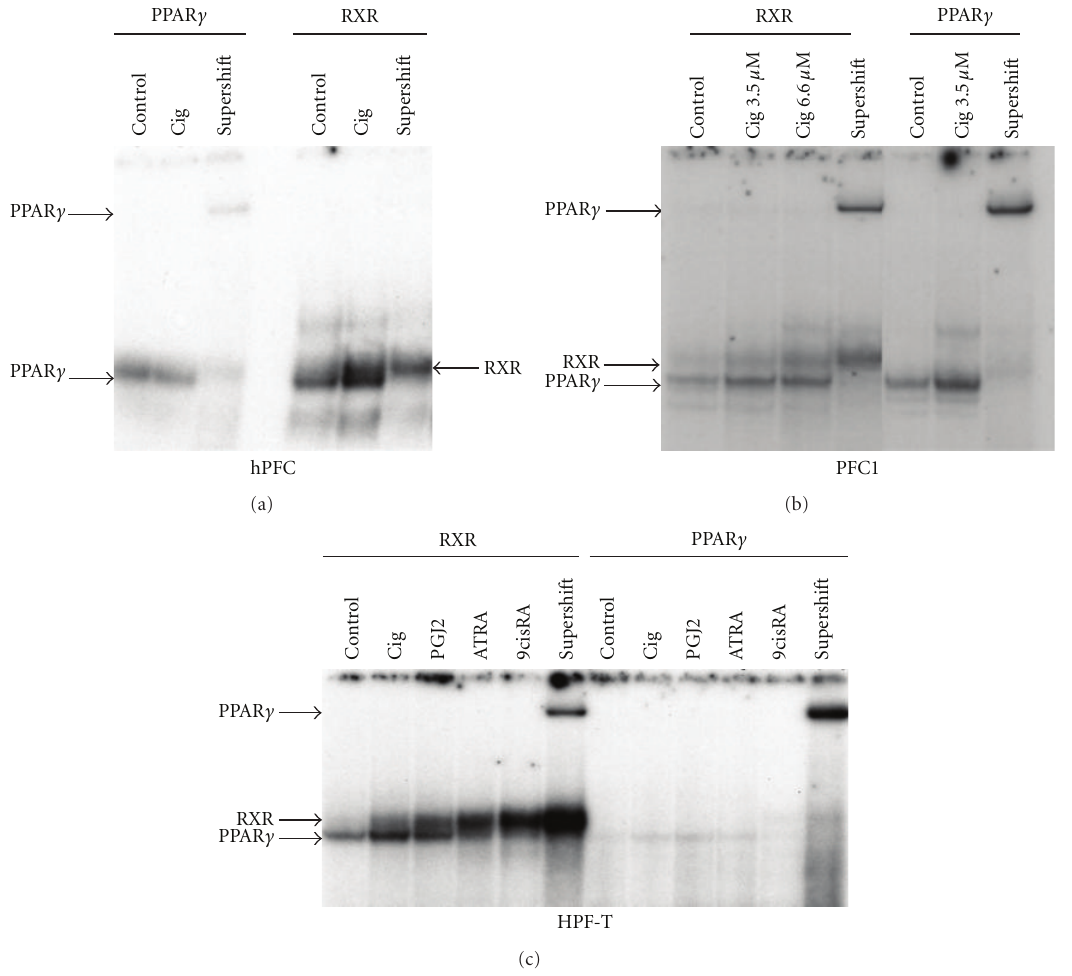
Figure 7: Gel shift analysis of PPAR γ . (a) Electrophoretic mobility shift analyses (EMSAs) in hPFC showed DNA binding of PPAR γ under control conditions, in the absence of ligand and in response to ciglitazone (3.3 μ M) stimulation using a PPAR γ consensus sequence. Supershift analyses with anti-PPAR γ antibodies were included to show the specificity of PPAR γ binding. Binding to a retinoid X receptor (RXR) consensus sequence was visible without ciglitazone treatment, but more pronounced after ligand binding to PPAR γ . Supershift analysis revealed that PPAR γ was present in the complex binding to RXR. (b) Analysis of PPAR γ binding in rat PFC1 cells. Two di ff erent concentrations of ciglitazone were used to show induction of dimer formation and binding to the RXR consensus sequence. A clear induction is visible with the PPAR γ probe already at the lower concentration. Supershift analysis showed that principally the lower of the two bands contained PPAR γ , while the upper band remained in place. (c) Analysis of PPAR γ binding in transformed HPF-T cells. Di ff erent stimulators were used for di ff erentiation purposes. Analysis of stimulation with ciglitazone (3.3 μ M) was compared to 15 Δ -prostaglandin J 2 (PGJ2 at 5 μ M), next to all trans retinoic acid (ATRA) and 9-cis-retinoic acid (9cisRA). The lower PPAR γ band was induced probing with RXR by ciglitazone and PGJ2, but ATRA and 9cisRA inductors for retinoid receptors did not stimulate PPAR γ binding to this consensus sequence. Using the consensus sequence of rat acyl coenzyme A oxidase, the signal was considerably weaker, but still induction of receptor binding was induced by specific ligands, while RXR binding to this probe appeared